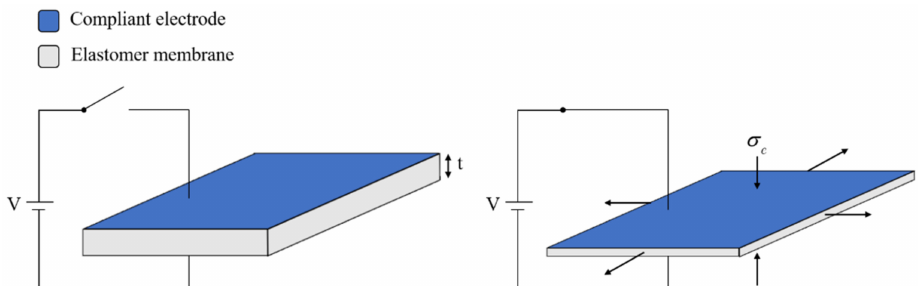
Figure 2. DE working principle: undeformed configuration on the left-hand side, deformed one due to electrical actuation on the right-hand side. Due to the combination of Maxwell stress σ e and incompressibility of the elastomer, the reduction in thickness results in an expansion of the